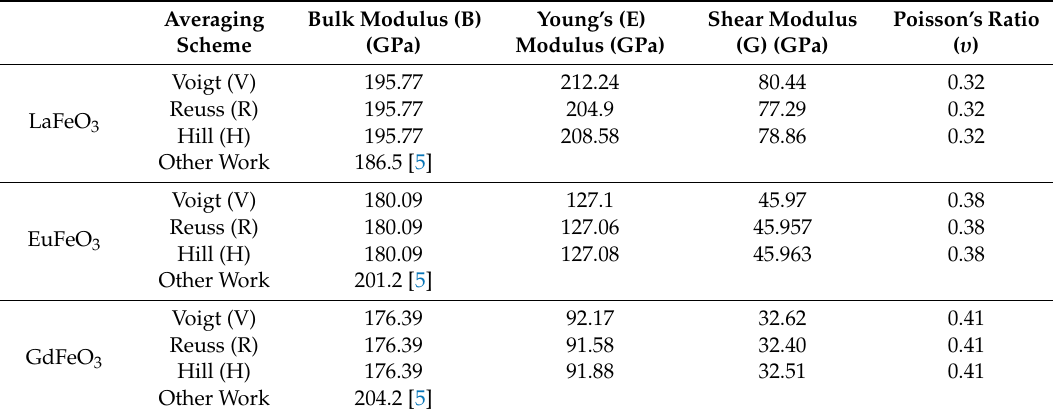
Table 3. Calculated results for bulk, Young, and shear moduli and Poisson ratio of RFeO 3 (R = La, Eu, Gd) structures by Voigt, Reuss, and Hill approaches.